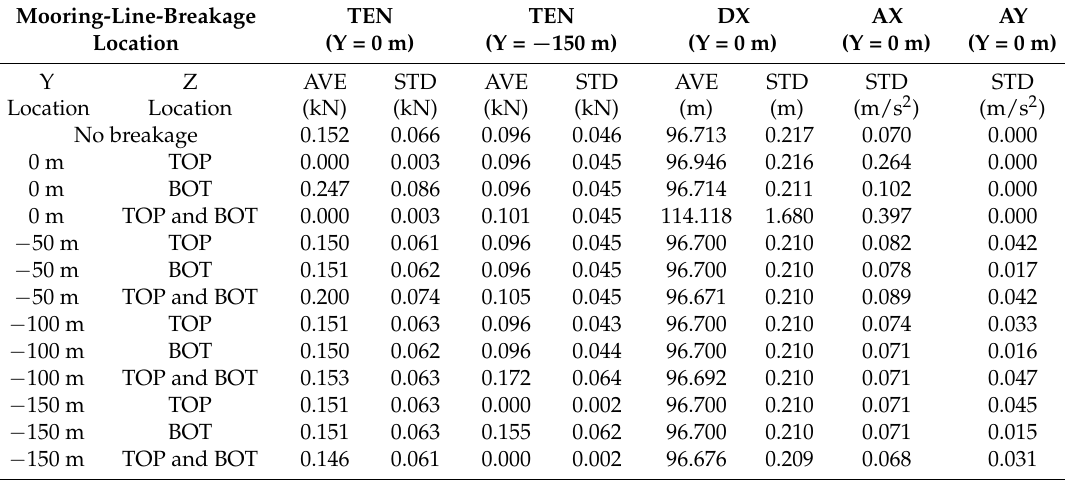
Table 5. Statistical data of mooring tension, surge motion of the location buoy, and acceleration of the net assembly in the X and Y directions in different mooring-line-breakage scenarios at H s = 2.0 m, T p = 7.0 s, and current velocity = 0.6 m/s.